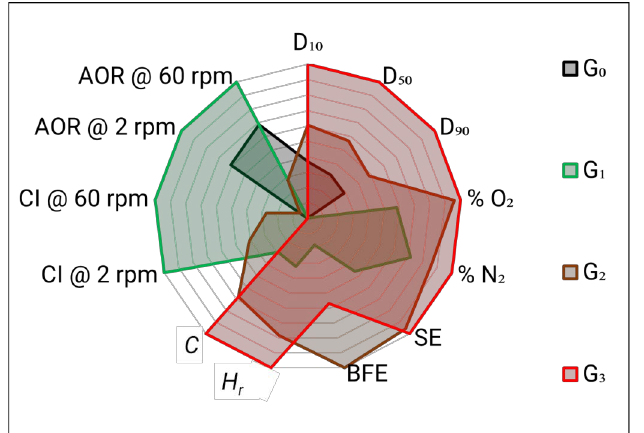
Figure 8. Radar diagram comparing the performance of G 0 , G 1 , G 2 , and G 3 powders w.r.t the D values, SE, BFE, nitrogen (in wt.%), oxygen (in wt.%), Hr , C , CI, and